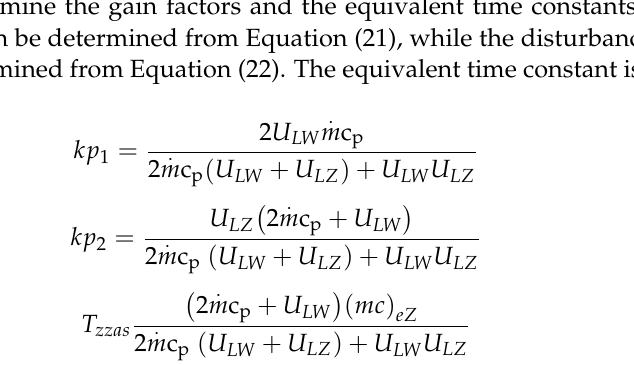
Figure 2. Block diagram of a domestic hot water storage tank.